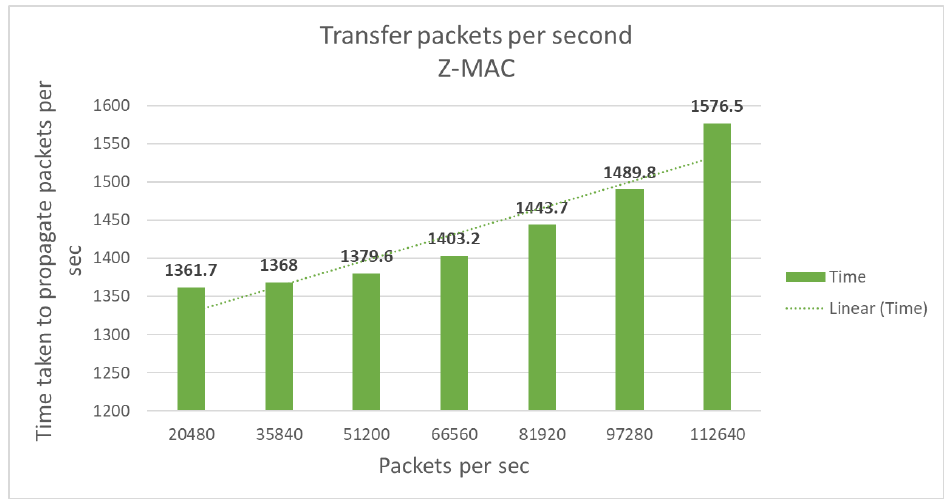
Figure 7. Transmission time using the basic Z-MAC protocol.